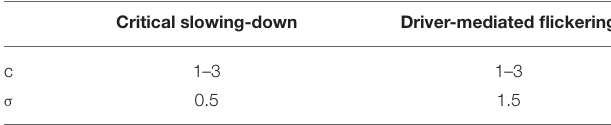
TABLE 1 | Characteristics of forcing (c) and noise intensities with σ representing standard deviation used in the two different